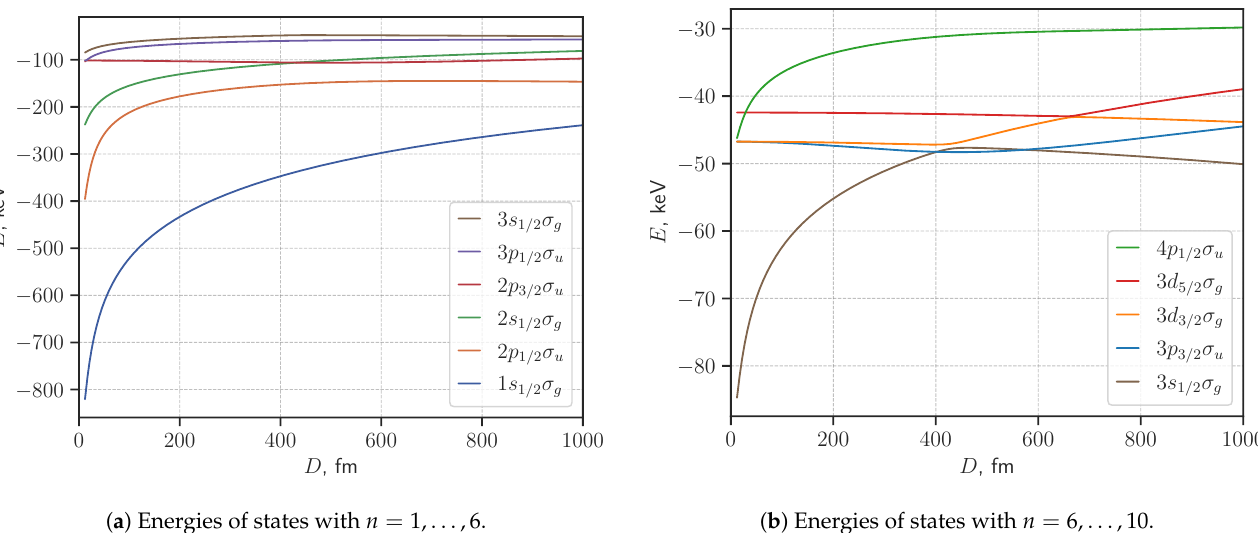
Figure 1. Electronic terms of the one-electron Pb 82 + –Pb 82 + quasimolecule.